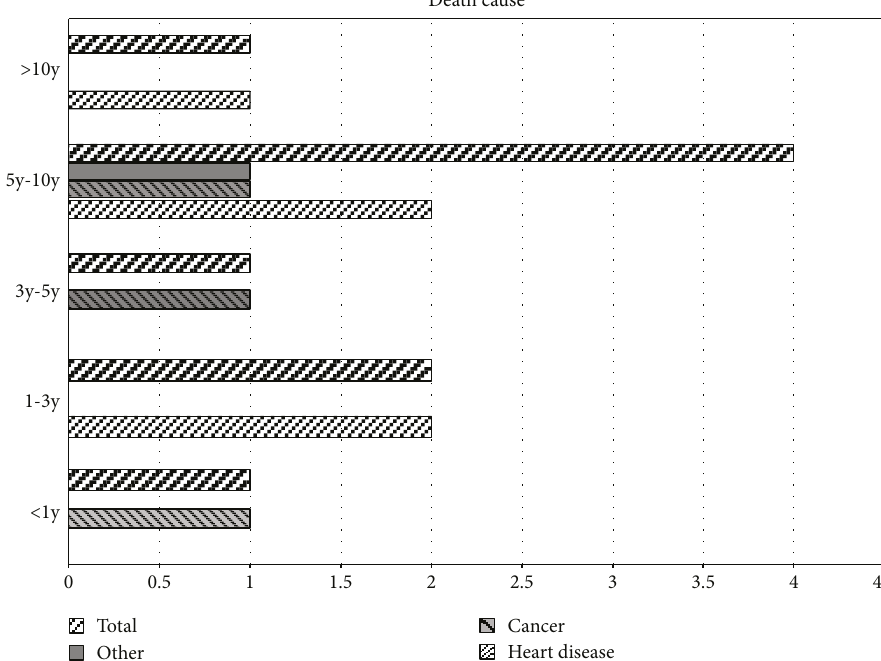
Figure 1: Analysis of survival and cause of death among elderly patients ( ≥ 70years) who underwent carotid stenting. Deaths that occurred later than 120 days after surgery were strati fi ed according to survival duration ( < 1 year, 1 – 3 years, 3 – 5 years, 5 – 10 years, and > 10 years. Di ff erent columns represent di ff erent causes of death, with “ other ” indicating death not related to heart disease or